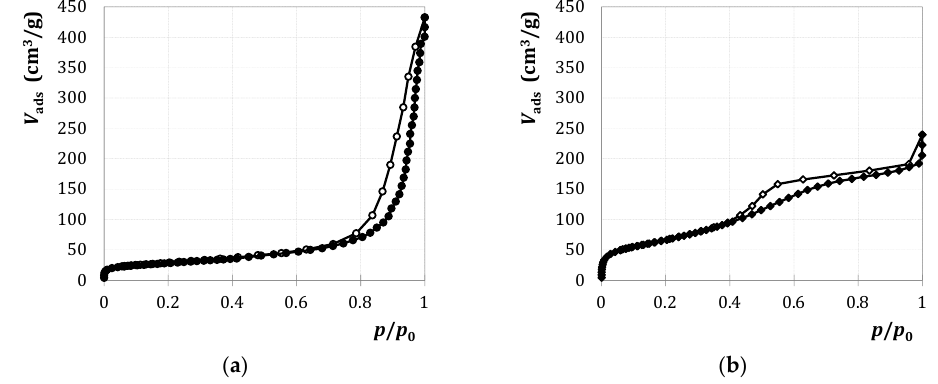
Figure 10. Nitrogen adsorption and desorption at 77 K on ( a ) M3(0)/SiO 2 90:10 and ( b ) M3(12)/SiO 2